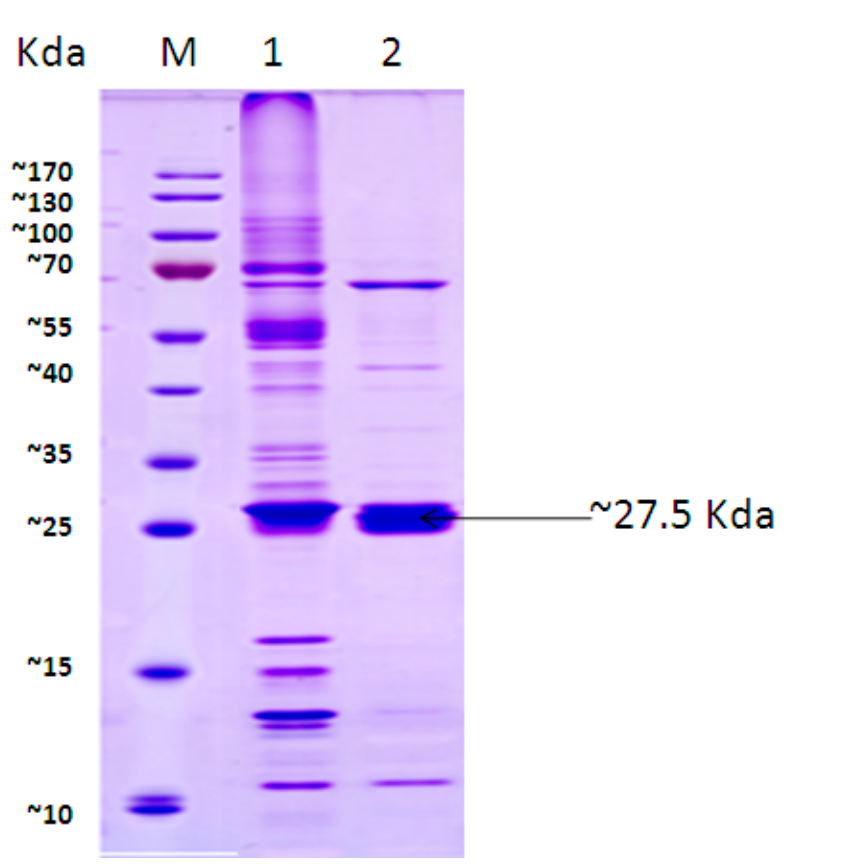
Figure 7. SDS ‐ PAGE analysis of cell extracts of E. coli JM109 with CC12Dos gene insert diluted 1:1 (lane 1) and 1:10 (lane 2); M PageRuler™ Prestained 10–170 kDa (Thermo Scientific).